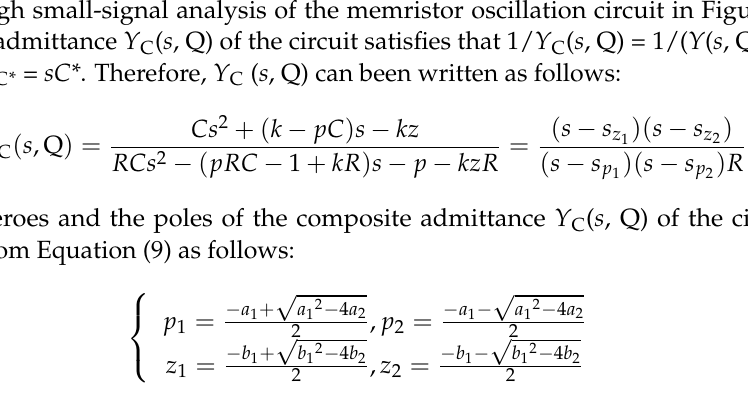
Figure 9. DC load line is superimposed on the V–I plane.